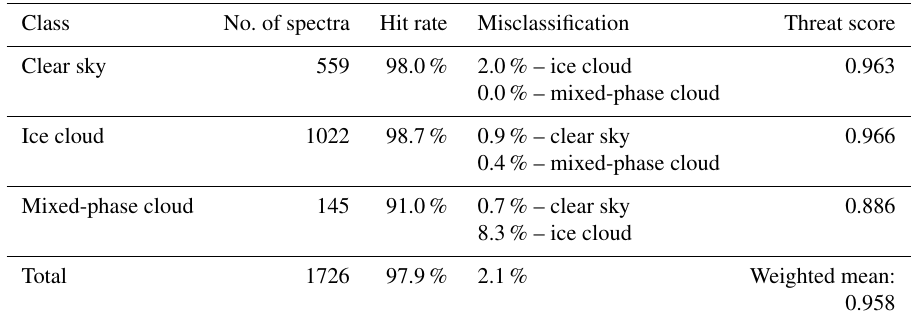
Table 3. Test set classification performed by CIC, using the optimal spectral range 380–1000cm − 1 .